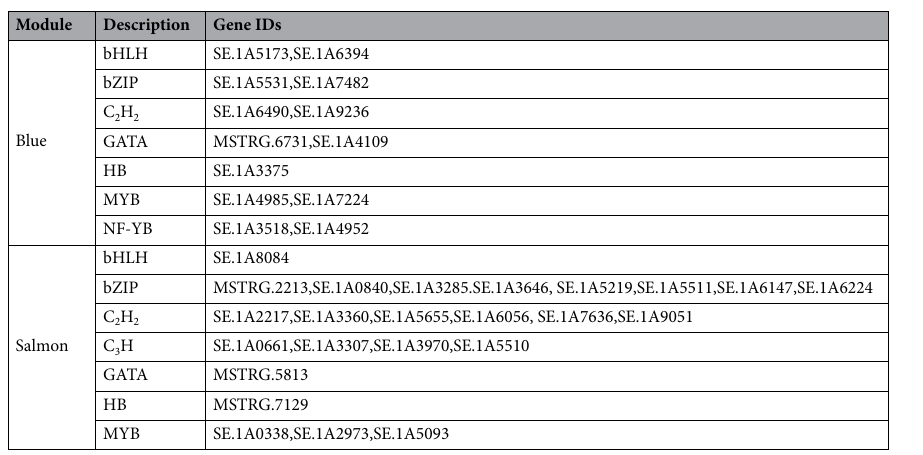
Table 2. Core TFs information